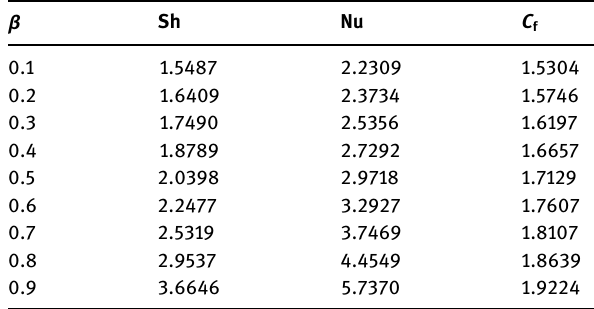
Table 4: Numerical analysis for Sh, Nu, and C f by increasing